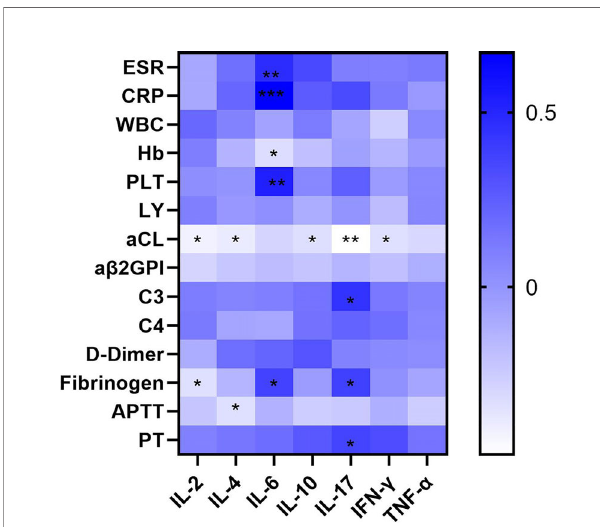
FIGURE 3 | Heatmap of correlation of the serum cytokine levels of a variety of cytokines with clinical and laboratory characteristics of APS patients ( ∗ p < 0.05, ∗∗ p < 0.01, and ∗∗∗ p < 0.001). The aCL titer was negatively correlated with many cytokines including IL-2, IL-4, IL-10, IL-17, INF- g , and IL-6 was positively correlated with ESR and